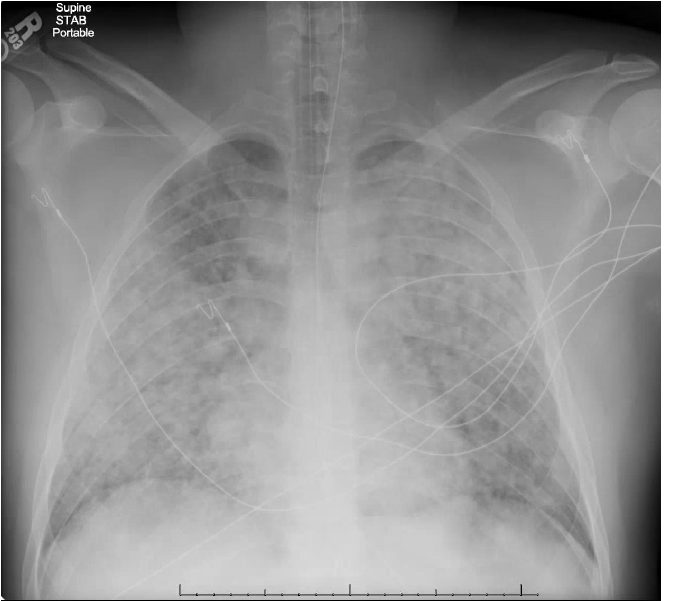
Image 2. Axial image at the level of the mainstem bronchi taken from a computed tomography of the chest obtained in the emergency department, showing diffuse, nodular opacities in both